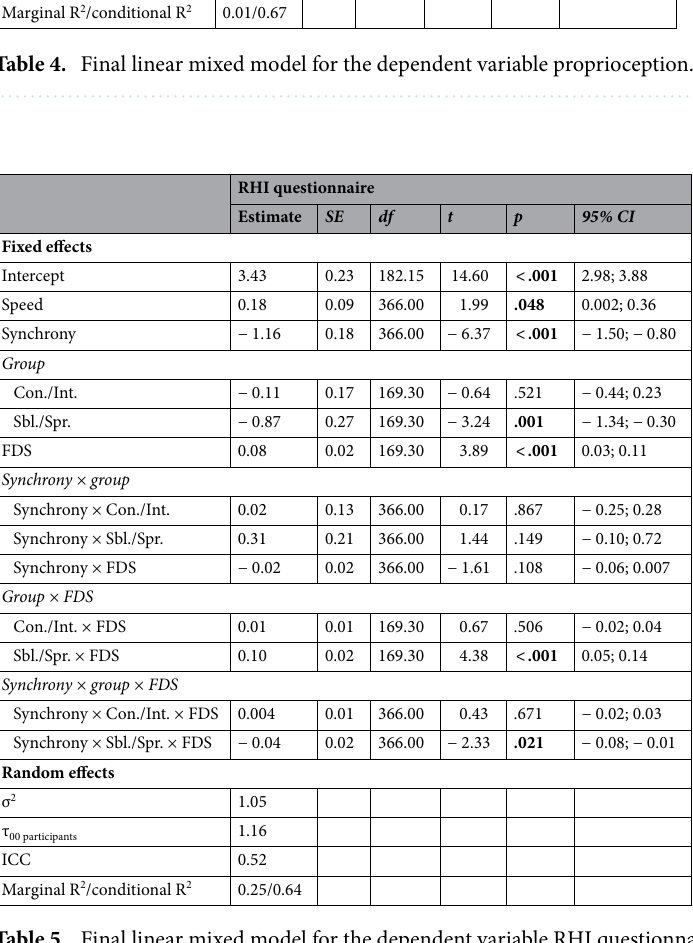
Table 5. Final linear mixed model for the dependent variable RHI questionnaire. Con. Control group, Int. Intervention, Sbl . Subliminal group, Spr . Supraliminal